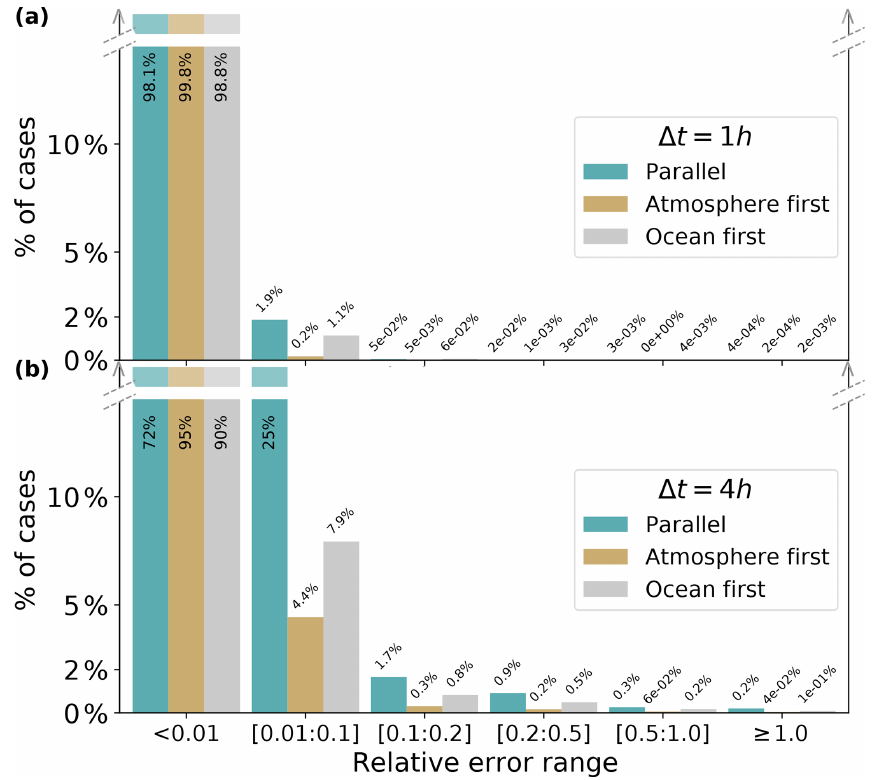
Figure 6. Same as Fig. 5, but with the relative error computed between the final iterated solution and the solution obtained after two iterations. See the legend in Fig. 4 for the explanation of the x axis. The ordinate axis is cut at 15% to make non-negligible errors